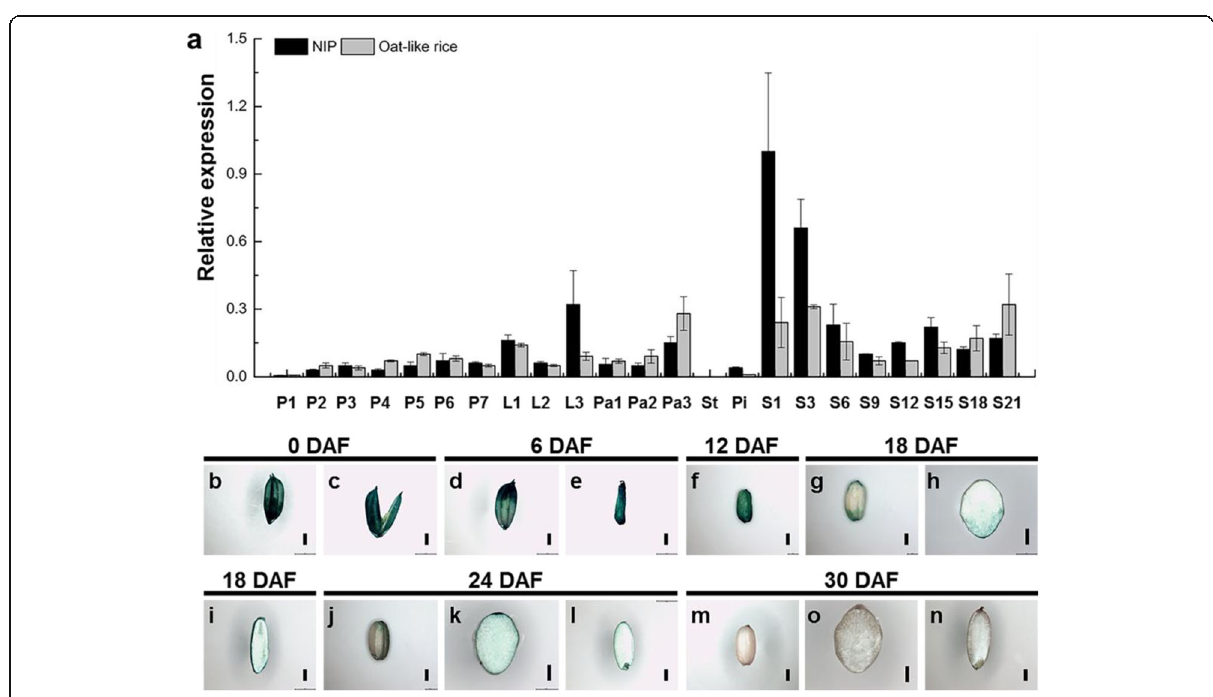
Fig. 7 Tissue-specific RNA expression pattern of the OsMADS1 and OsMADS1 Olr . a Relative expression levels of the OsMADS1 and OsMADS1 Olr in NIP and Oat-like rice, respectively. Samples from panicles, floral organs and grains at representative developmental stages were analyzed. P1, 0 – 3 mm panicles; P2, 3 – 15 mm panicles; P3, 15 – 50 mm panicles; P4, 50 – 100 mm panicles; P5, 100 – 150 mm panicles; P6, 150 – 200 mm panicles; P7, panicles longer than 200 mm; L1, lemmas of spikelets from 100 to 150 mm panicles; L2, lemmas of spikelets from 150 to 200 mm panicles; L3, lemmas of spikelets from panicles longer than 200 mm; Pa1, paleae of spikelets from 100 to 150 mm panicles; Pa2, paleae of spikelets from 150 to 200 mm panicles; Pa3, paleae of spikelets from panicles longer than 200 mm; St, stamens of spikelets before anthesis from panicles longer than 200 mm; Pi, pistils of spikelets before anthesis from panicles longer than 200 mm; S1, 1 DAF pistils and hulls; S3, 3 DAF grains; S6, 6 DAF grains; S9, 9 DAF grains; S12, 12 DAF grains; S15, 15 DAF grains; S18, 18 DAF grains; S21, 21 DAF grains. DAF, Days After Fertilization. The value of OsActin mRNA was used as an internal control for data normalization, and the expression level of OsMADS1 in S1 (1 DAF pistils and hulls) of NIP were set as 1.0. Values are means ± SDs of three replicates. b-n Histochemical staining analysis of GUS expression driven by OsMADS1 promoter in transgenic grains at representative developmental stages. b and c A mature spikelet ( b ) and hull of a mature spikelet ( c ). d A 6 DAF grain. e-g, j and m Brown rice. h, k and o The transverse section of brown rice. i, l and n Longitudinal section of brown rice. Bars: ( b - n ) 1